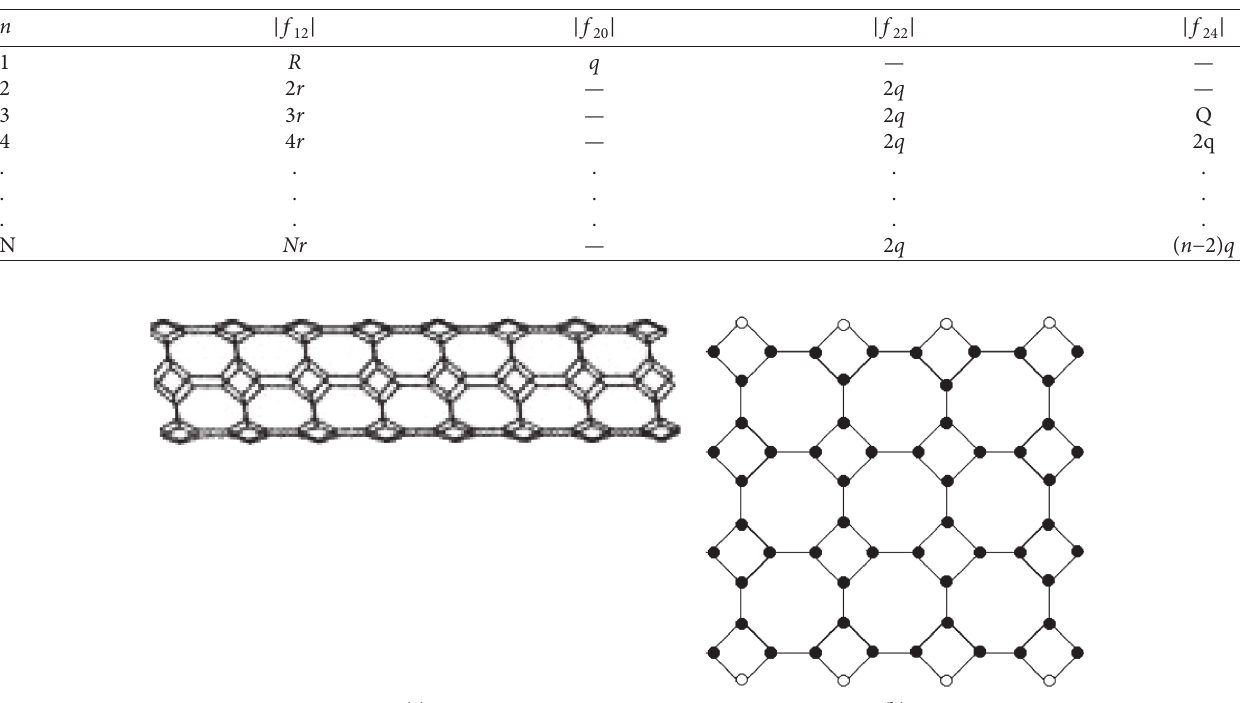
Figure 1: (a) 2D lattice of TUC Table 1: Numbers of f